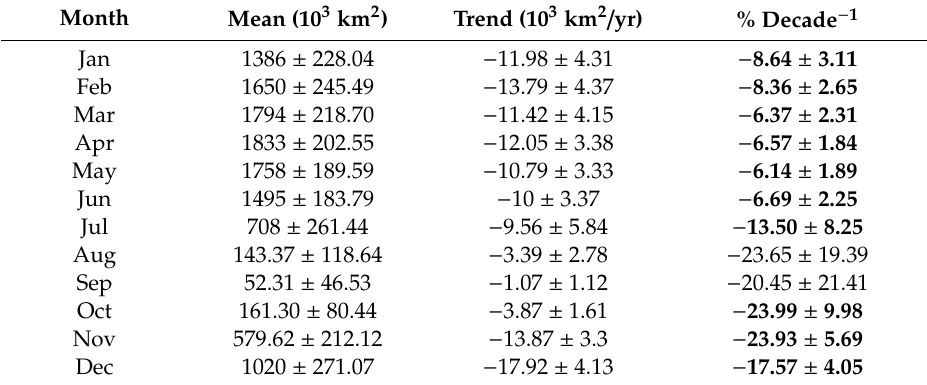
Table 1. Monthly landfast ice extent for the period from 1976 to 2018. The F-test is used to determine the significance of the trend independent of the statistical data, and bold numbers indicate that the trends are significant at the 0.01